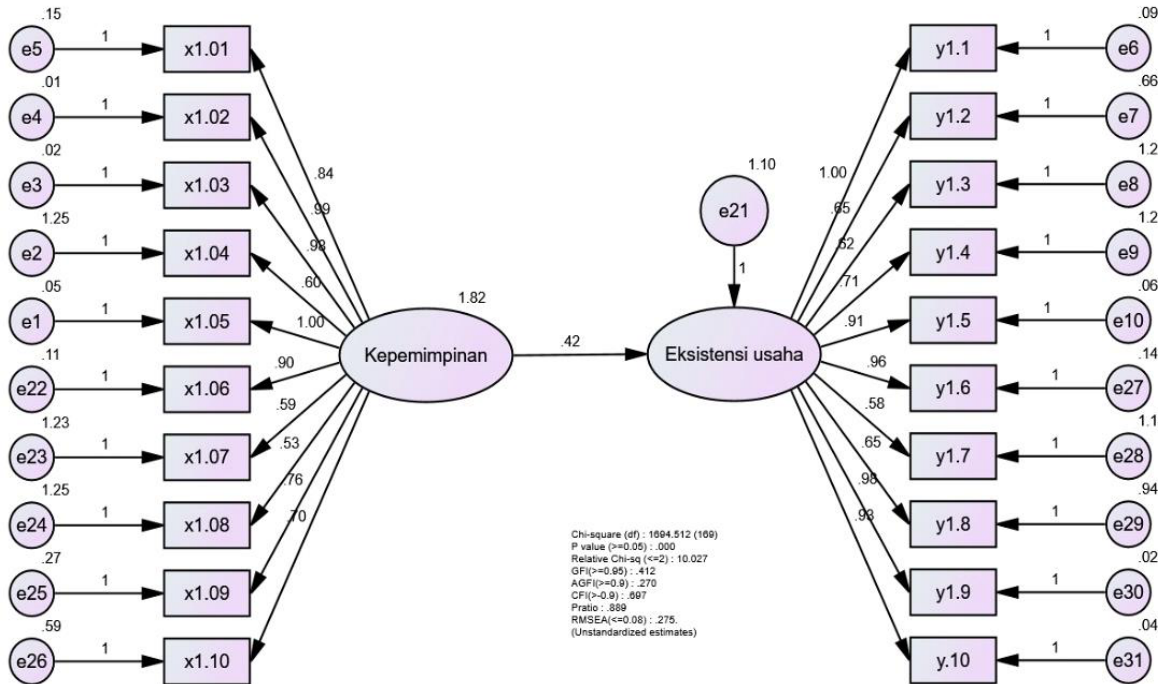
Figure 2. Exogenous Construct Model of Leadership Variables on Business